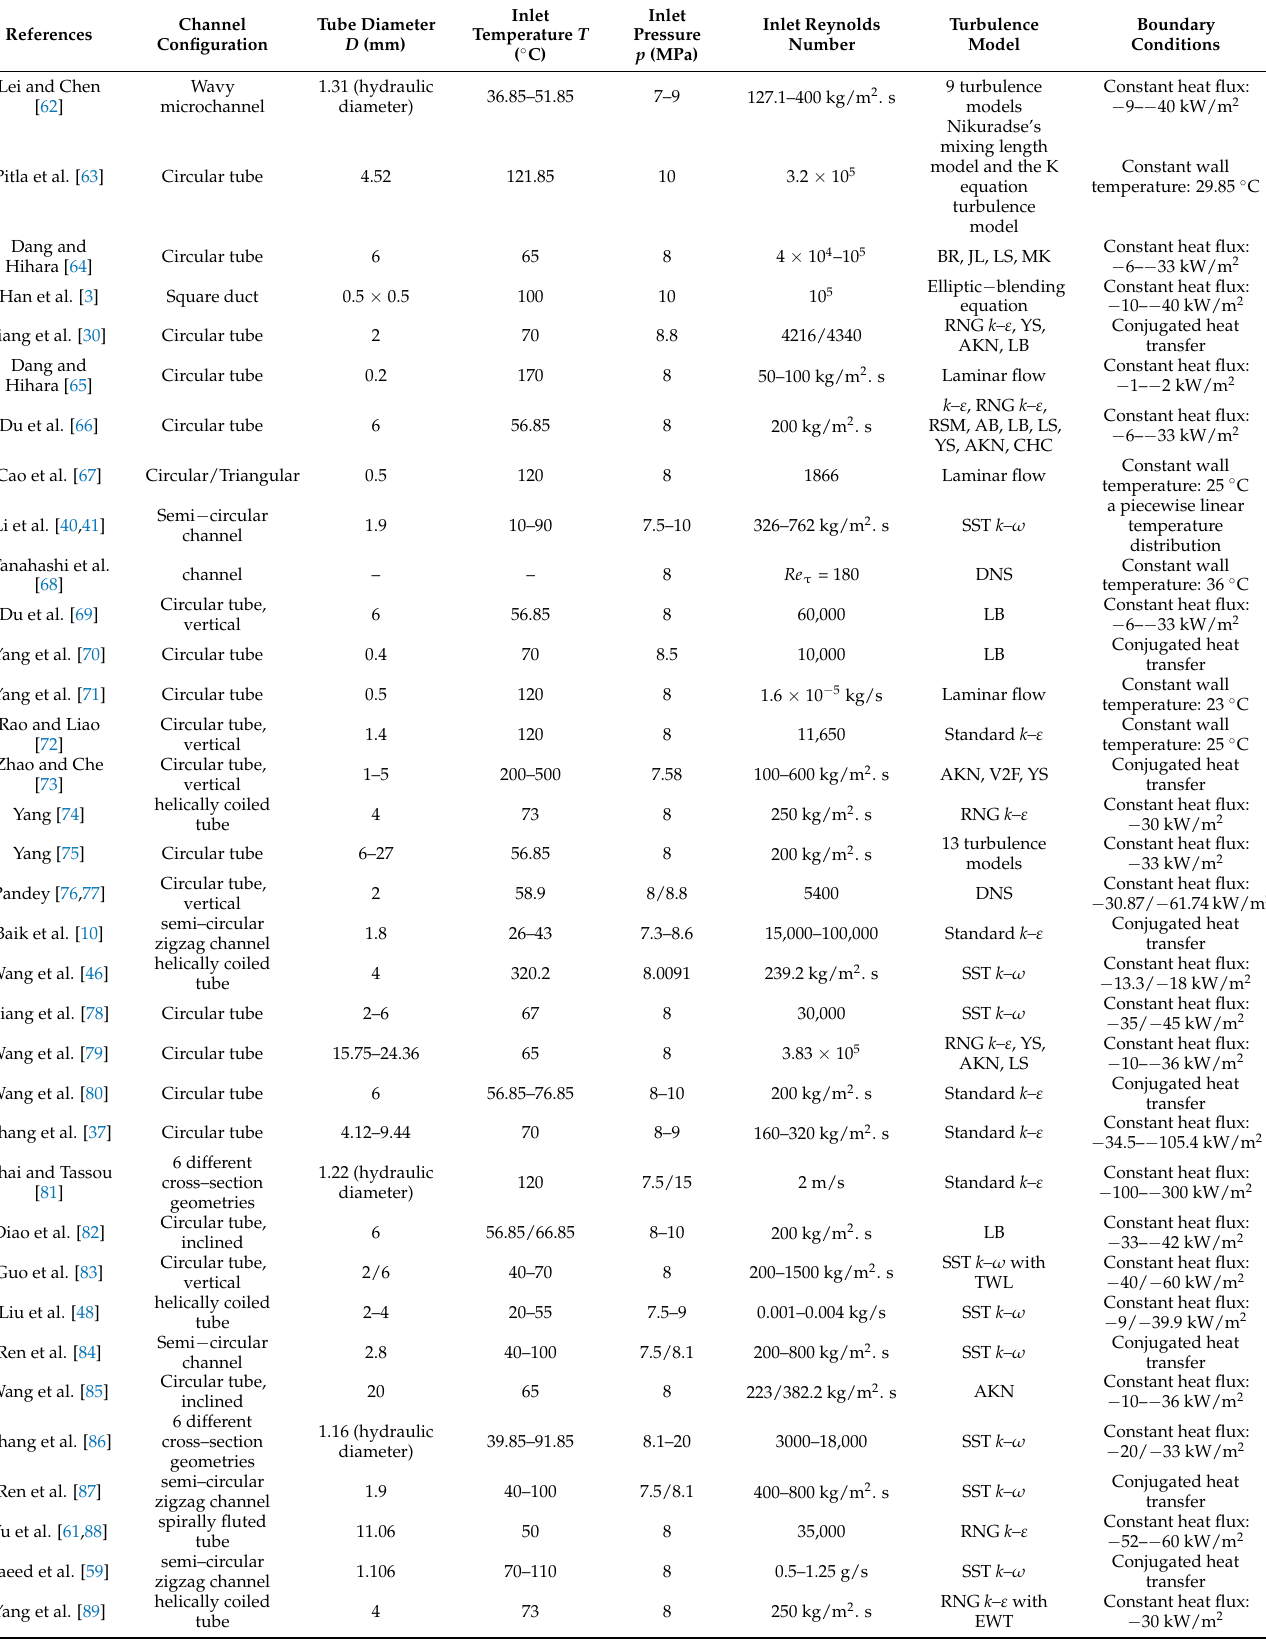
Table 2. Heat transfer simulations under SCO 2 cooling